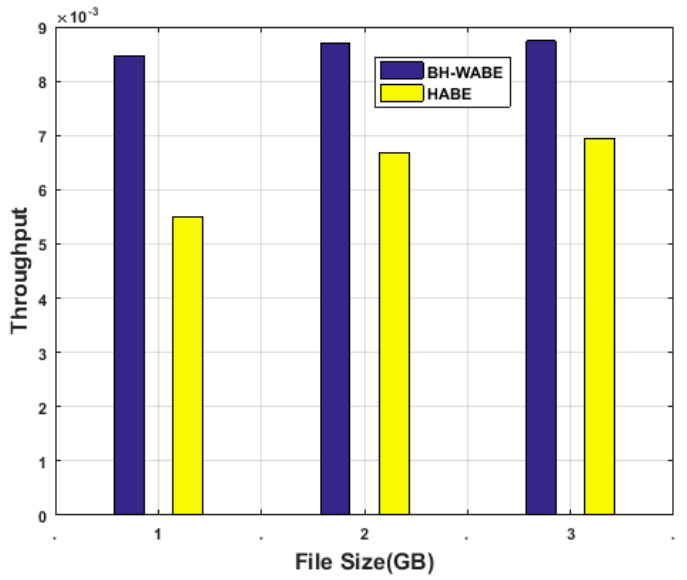
Figure 7. Comparison on throughput of HABE and BH-WABE.